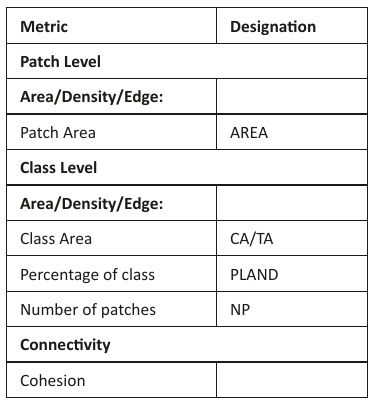
Table 2. FRAGSTATS metrics at patch and class levels. Landscape level metrics were not analyzed because of their little interpretative value and identical behavior at class level.